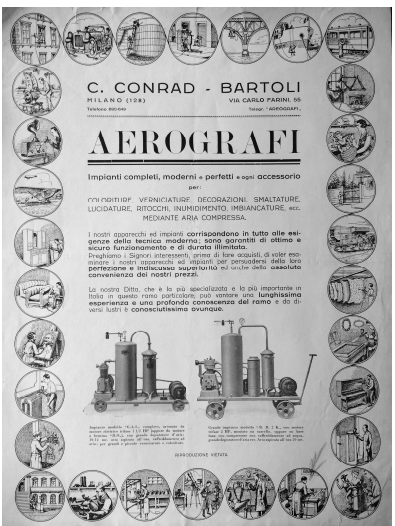
Figure 2. A “Conrad-Bartoli” company advertisement for airbrush. In the circles that frame